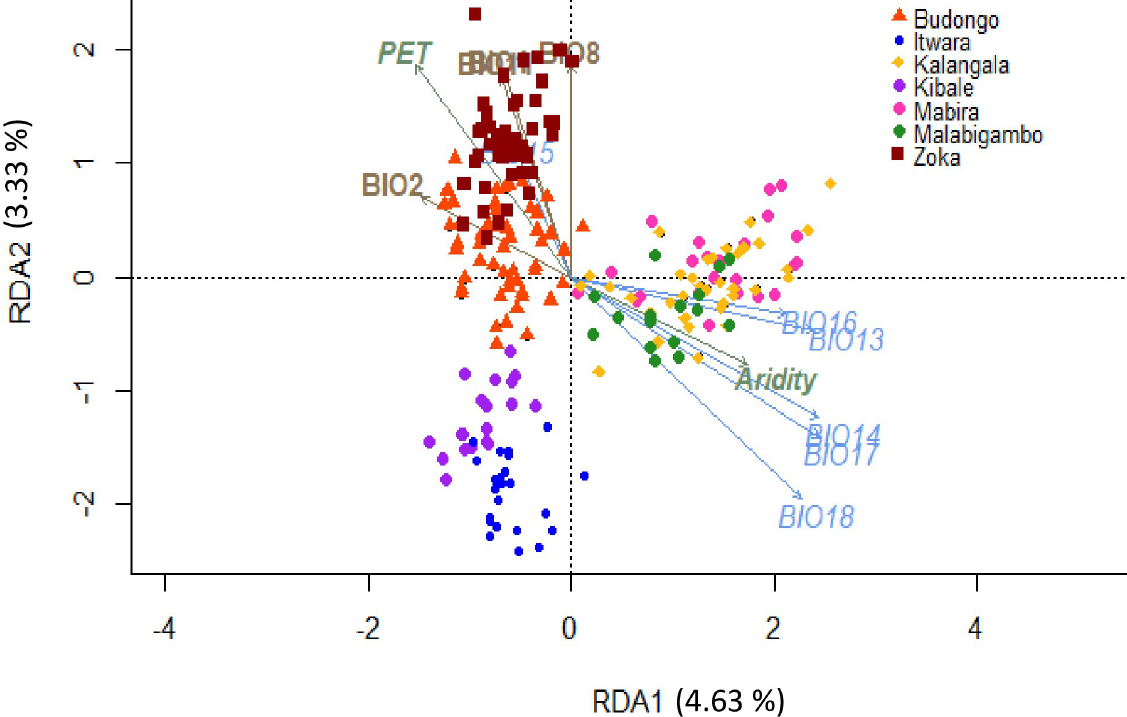
Fig 4. Constrained redundancy analysis (RDA) of the effects of environmental parameters on the allelic diversity of Ugandan C . canephora wild populations. Twelve out of the 22 environmental variables used in this study significantly and collectively explained 16.3% of the total variation in allelic diversity. Colour codes are the same as in Fig 1. The first and second constraining axes explained 4.63% and 3.33% of the total genetic diversity,